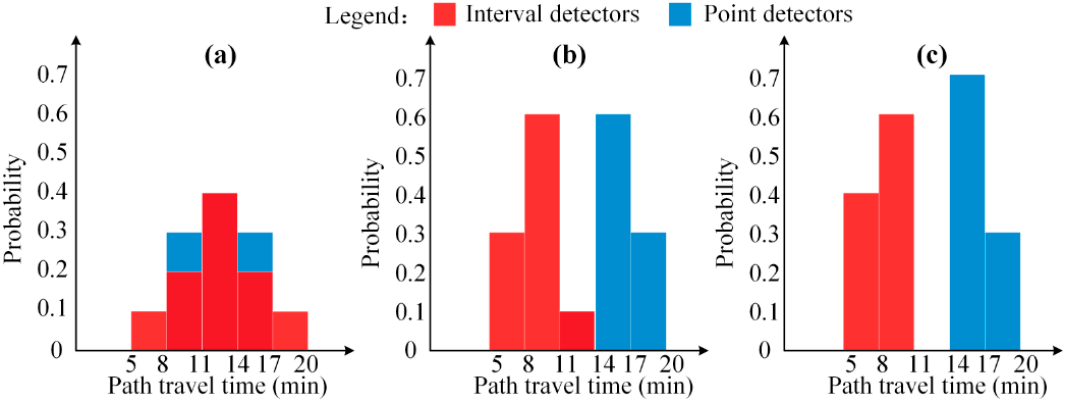
Figure 3. Typical information conflict situations of interval and point detectors: ( a ) low conflict, ( b ) high conflict, ( c ) complete conflict.